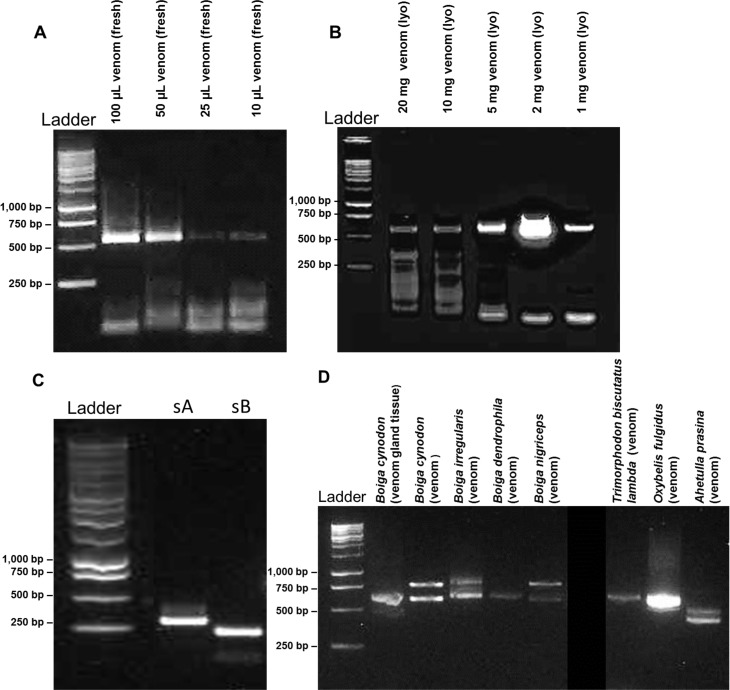
Agarose gel electrophoresis showing cDNA transcripts amplified from mRNA in venomous snake venoms.Various amounts of fresh venom (A) and lyophilized venom (B) from Crotalus simus tzabcan were used to determine optimal amplification conditions for phospholipase A2 transcripts. Regions of phospholipase A2 Mojave toxin subunit A (sA) and subunit B (sB) cDNAs were amplified to demonstrate transcript detectability in Crotalus scutulatus scutulatus venom (C). Three-finger toxin cDNA sequences were also amplified from mRNA derived from venoms of rear-fanged snakes (D).